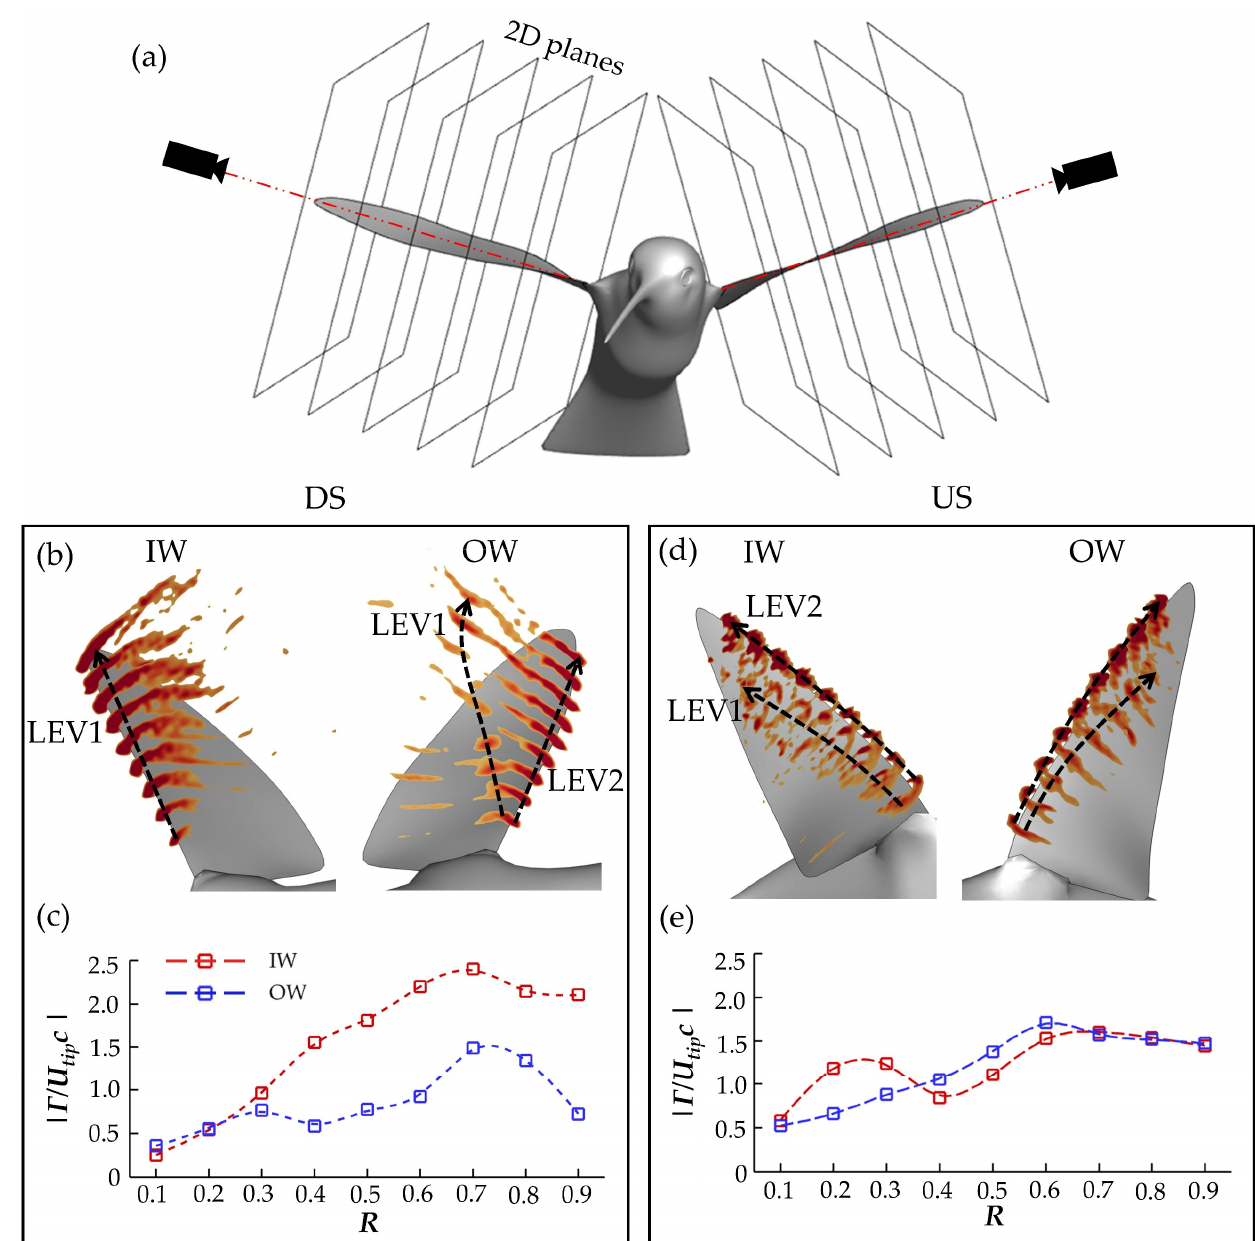
Figure 10. ( a ) Schematic of camera placement for computing the 2D spanwise slice cuts; ( b ) IW and OW vorticity contours at peak DS force production with ( c ) corresponding Γ , normalized by average U tip c ; ( d , e ) represent the same information as ( b , c ) but for the